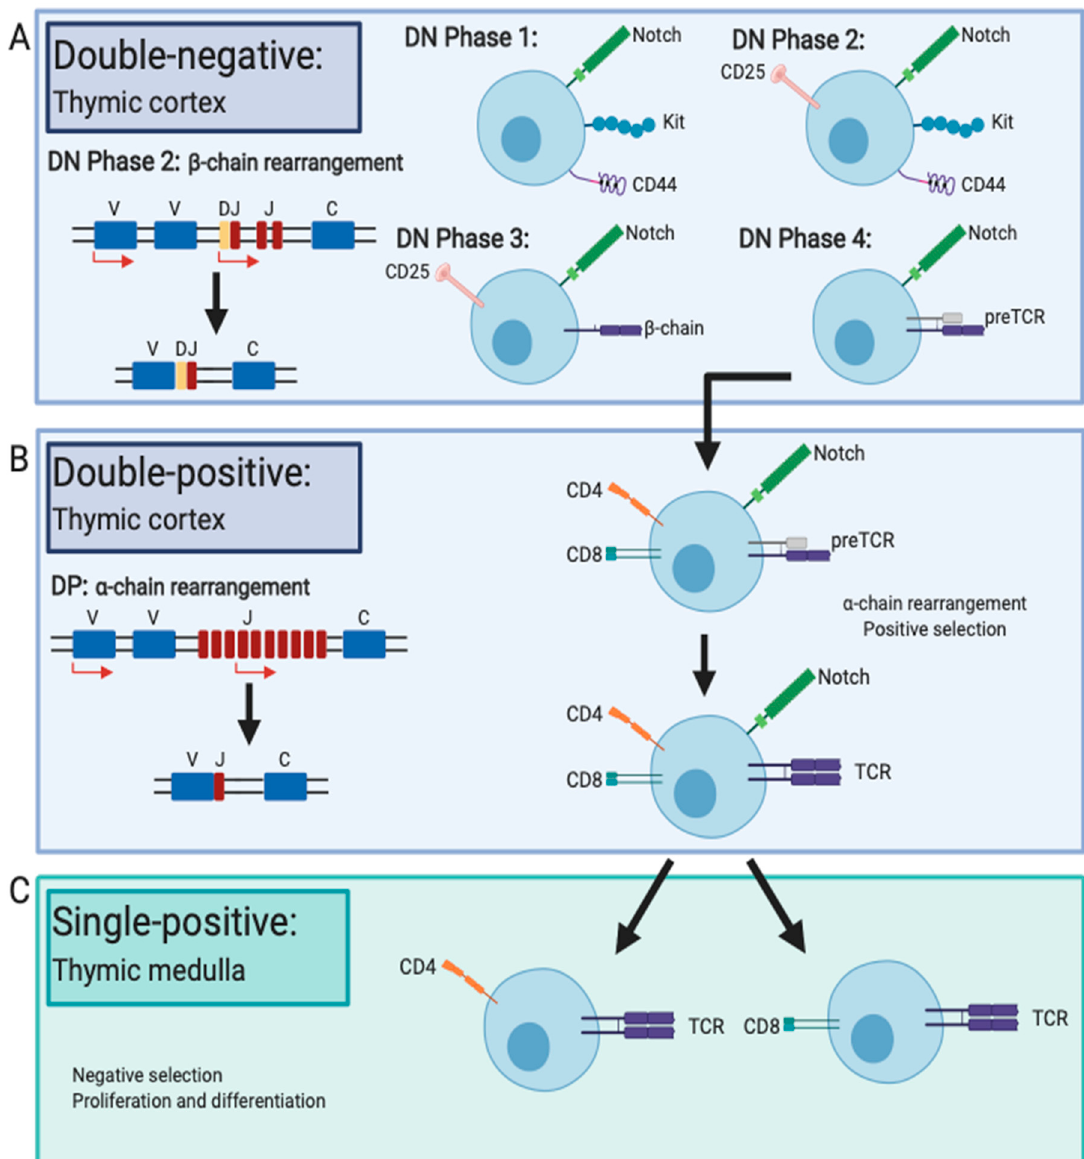
Figure 1. T cell di ff erentiation in the thymus. ( A ) Immature thymocytes in the thymic cortex upregulate Notch, Kit and CD44 to begin di ff erentiation in double-negative (DN) phase 1. As CD25 expression is upregulated, thymocytes progress into DN phase 2, where T cell receptor (TCR) β -chain rearrangement begins. Rearrangement of the β -chain locus of the TCR, from the Diversity β ( D β ) to the Joining β ( J β ) region, begins, and as expression of CD44 and Kit are reduced, V β to D β J β rearrangements occur and cells progress into the DN3 phase. Only cells that successfully produce a reproductive β -chain survive and progress into DN phase 4, where the β -chain is paired with a surrogate pre- α chain to form the pre-TCR. ( B ) During the DN4 phase, expression of CD4 and CD8